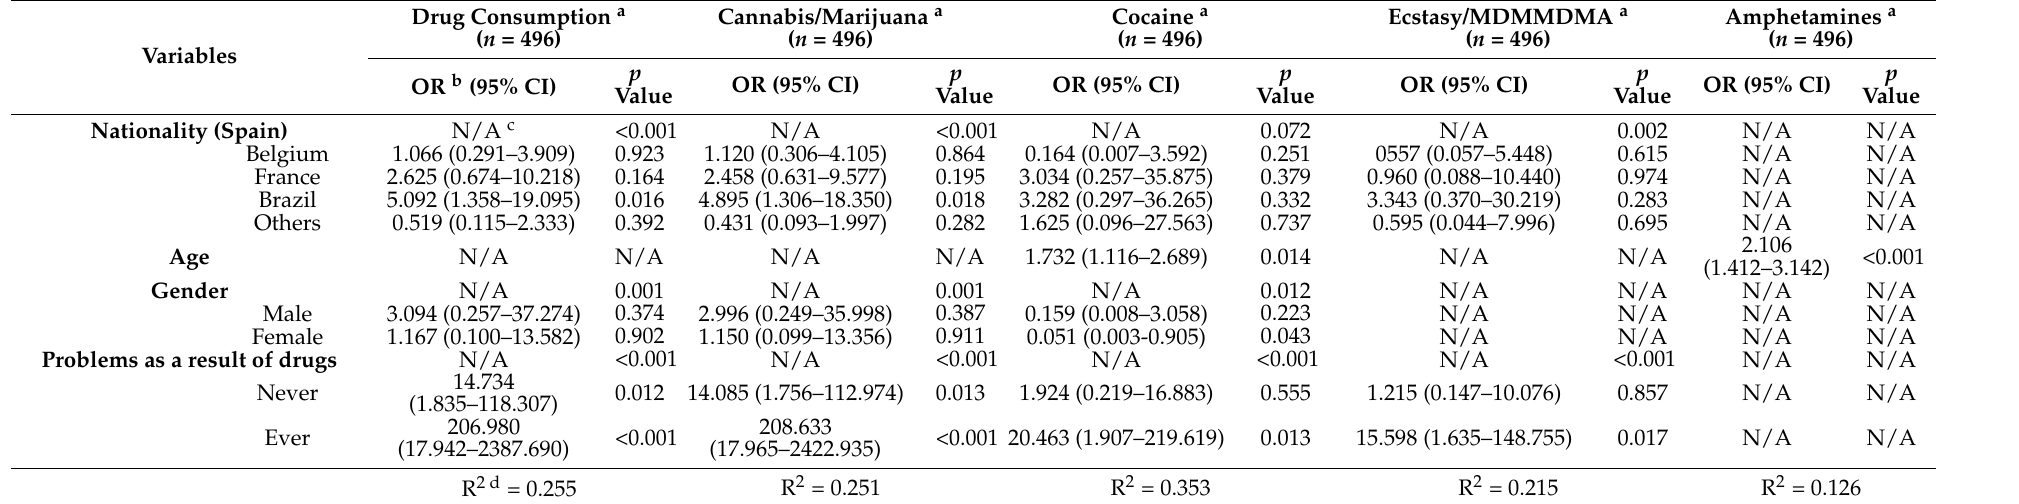
Table 6. Association between the characteristics of the participants and Drug Use Module (consumption ever in